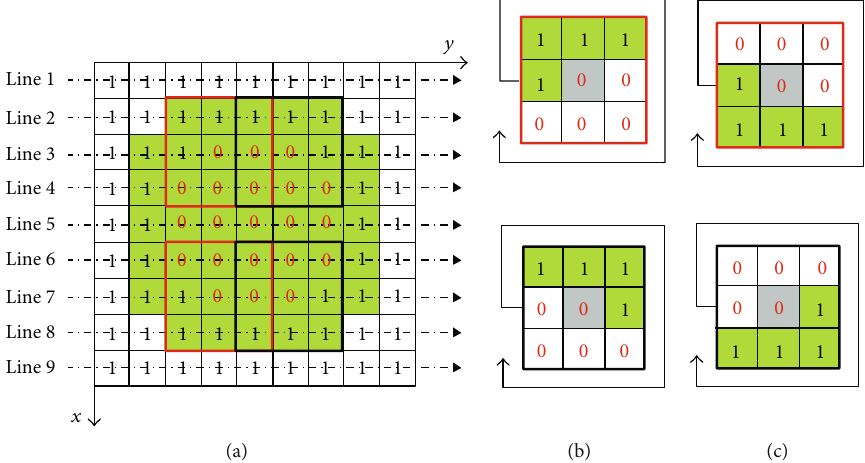
Figure 7: Binarized image lines scan to determine contour: (a) local binarized image pixel line scan; (b) third line scan; (c) seventh line